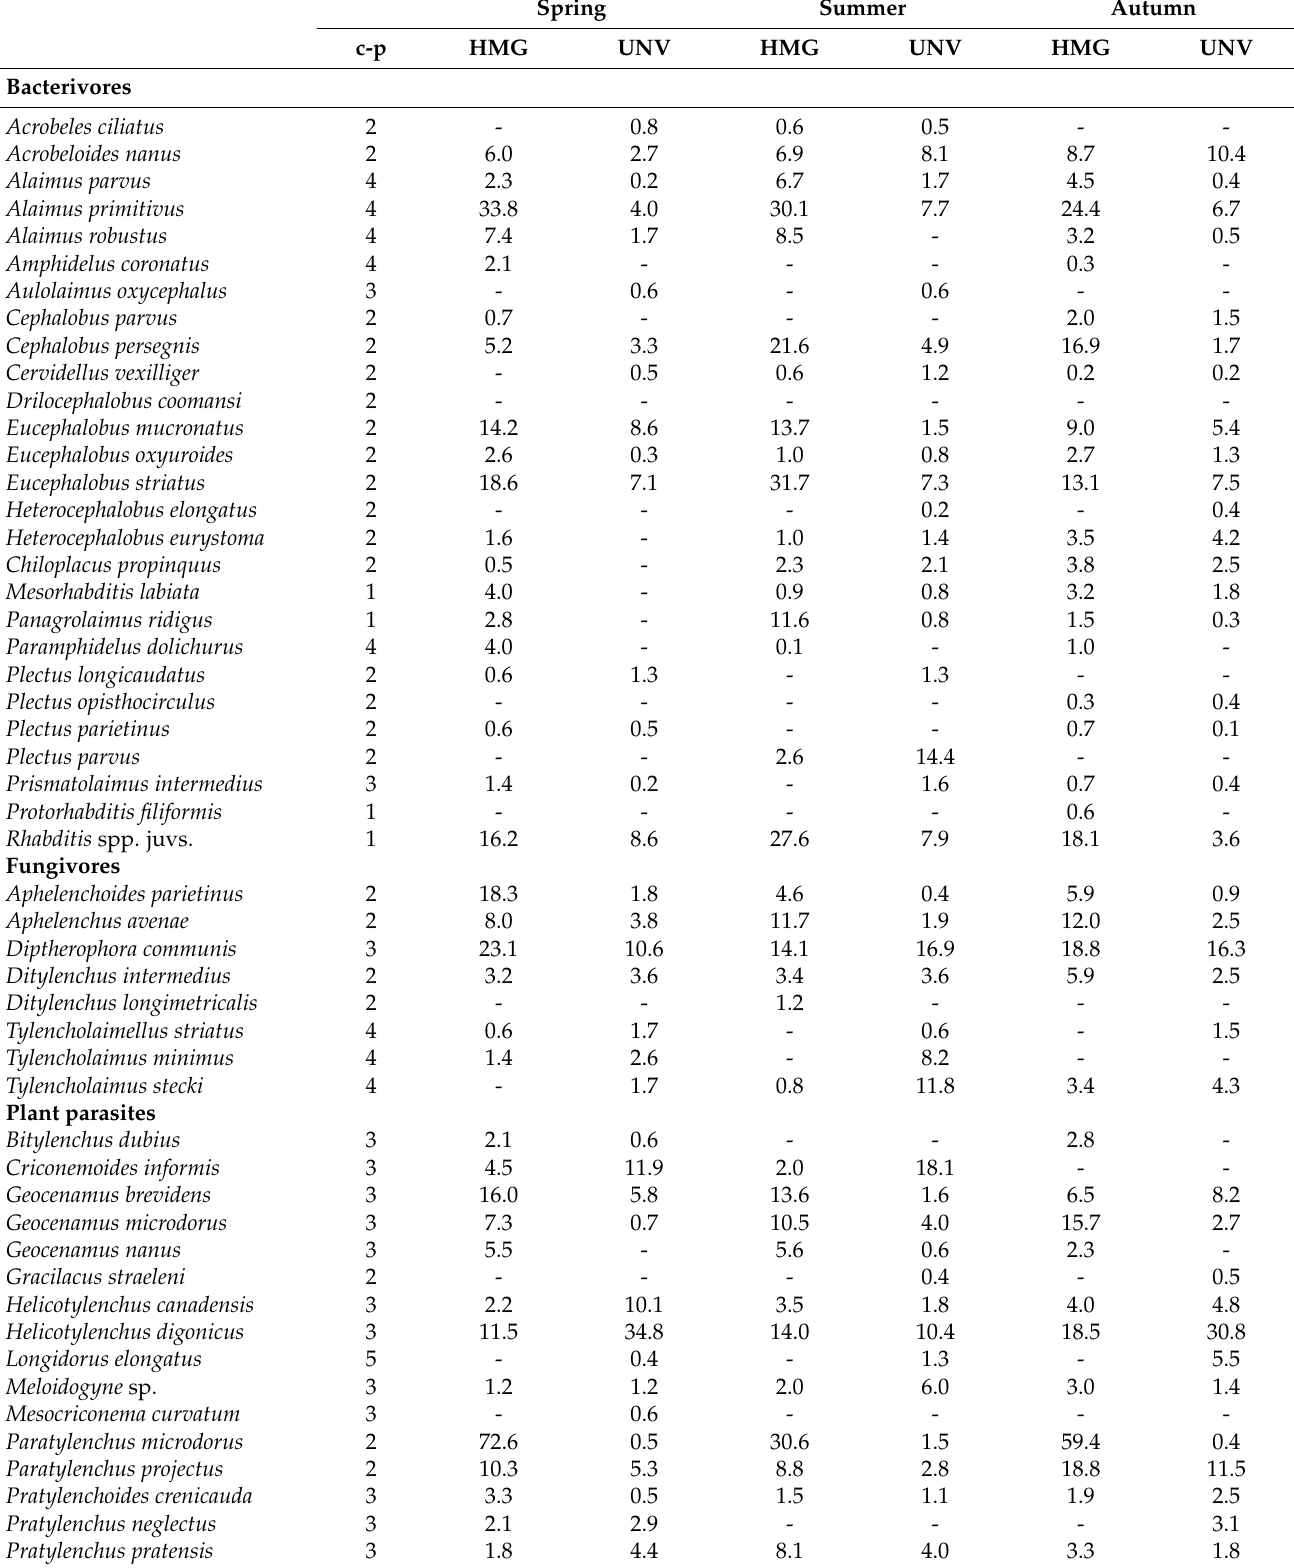
Table 3. Mean abundance of nematode species (100 g/dry soil) of investigated plots of Heracleum mantegazzianum invaded and uninvaded control plots in the three vegetation seasons and two years 2017, 2018 ( n = 10). Spring Summer